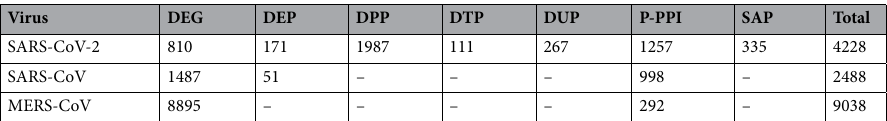
associated proteins (SAPs) (Table 1). For the SARS-CoV-2, VIGs included 810 DEGs, 171 DEPs, 1,987 DPPs, 111 DTPs, 267 DUPs, 1,257 P-PPIs and 335 SAPs. Only a few genes overlapped between different kinds of VIGs (Table S2). For example, only 13 genes were observed in both the DEGs and DEPs. This suggested that different kinds of VIGs capture complementary aspects of the viral infection. Therefore, seven kinds of VIGs from multi- omics data were incorporated for a better understanding of the pathogenesis of coronavirus infection. For the SARS-CoV, 2,488 VIGs were obtained which included 1,487 DEGs, 51 DEPs and 998 P-PPIs; for the MERS-CoV, 9,038 VIGs were obtained which included 8,895 DEGs and 292 P-PPIs (Table 1). Only a few genes overlapped between different kinds of VIGs for both SARS-CoV and MERS-CoV. The DGs for both AD and PD were obtained from the HGMD and DisGeNET databases (Materials and Methods). A total of 886 DGs for AD were obtained which included 105 and 852 genes obtained from the HGMD and DisGeNET databases, respectively (Table S1). A total of 481 DGs for PD were obtained which included 85 and 450 genes obtained from the HGMD and DisGeNET databases, respectively (Table S1). The inflammation and stress response‑related molecular functions were common in coronavi‑ rus infection and AD. The enriched gene ontology (GO) terms and KEGG pathways in the VIGs of three coronaviruses and DGs of two neurodegenerative diseases were obtained firstly (Table S3). Then, the common genes and functions between VIGs of all three coronaviruses and DGs of AD were analyzed. 38 genes were found to be involved in infection of three coronaviruses and AD (Fig. 2 and Table S4). A total of 8 KEGG pathways, and 95, 5, 25 GO terms in the domain of Biological Process, Molecular Function, Cellular Component, respec- tively, were observed between the enriched functions in VIGs of three coronaviruses and DGs of AD (Fig. 2 and Table S5). In the shared KEGG pathways, six pathways were connected in the pathway network (Fig. 3A). Three path- ways including the “MAPK signaling pathway”, “TNF signaling pathway” and “NF-kappa B signaling path- way” were reported to be involved in inflammation and immune response. Among them, the “MAPK signaling pathway” was the hub node in the pathway network and connected to four pathways. Interestingly, two virus infection-related pathways including “Coronavirus disease” and “Epstein-Barr virus infection” were enriched in DGs of AD, while two neurodegenerative disease-related pathways including “Amyotrophic lateral sclerosis” and “Lipid and atherosclerosis” were enriched in VIGs of three coronaviruses. In the shared GO terms in the domain of Biological Process, when analyzing the top ten GO terms, three of them were related to response to oxidative or chemical stress and five of them were related to regulation of biological processes such as signaling and catabolic process (Fig. 3B). When analyzing all 95 GO terms, they were grouped into 9 clusters (Fig. 3C). The largest cluster was related to responses to signaling, stress, regulations, and so on; the second cluster was related to regulation of biological processes such as signaling and catabolic process; other clusters were related to development, organization, localization, RNA silencing, viral infection, and so on (Fig. 3C). In the shared GO terms in the domain of Molecular Function, all five GO terms were binding-related such as “ubiquitin protein ligase binding” and “chaperone binding” (Table S6). In the shared GO terms in the domain of Cellular Component, most GO terms were related to vesicle-like structures in the cytoplasm such as the vesicle, granule, endosome, vacuole, and so on (Table S6). Common molecular signatures between coronavirus infection and PD were also observed in AD. Then, the common genes and functions between VIGs of all three coronaviruses and DGs of PD were analyzed. 19 genes were found to be involved in the infection of three coronaviruses and PD (Fig. 2 and Table S4). A total of 7 KEGG pathways, and 97, 5, 22 GO terms in the domain of Biological Process, Molecular Function, Cellular Component, respectively, were observed between the enriched functions in VIGs of three coronaviruses and DGs of PD (Fig. 2 and Table S5). Interestingly, most of the enriched functions shared between coronaviruses and PD were also found in AD (Fig. 2 and Table S5). For example, 100%, 88%, 89% and 91% of enriched KEGG pathways, GO terms in the domain of Biological Process, Molecular Function, Cellular Components shared between the SARS-CoV-2 and PD were also found in AD (Table S5). Seven genes were involved in infections of three coronaviruses and two neurodegenerative diseases.